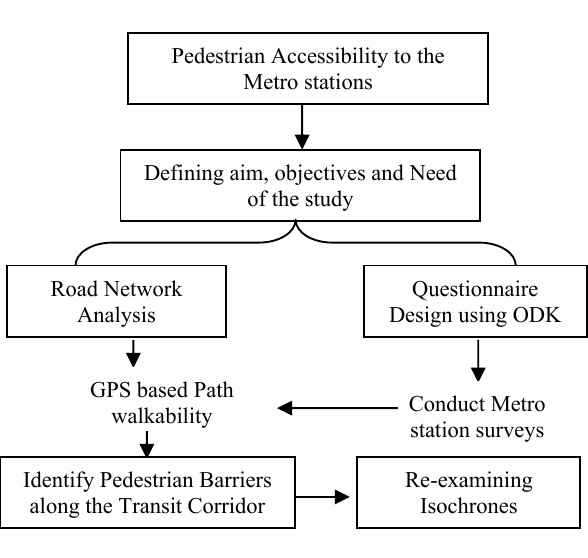
Figure 1 . Research